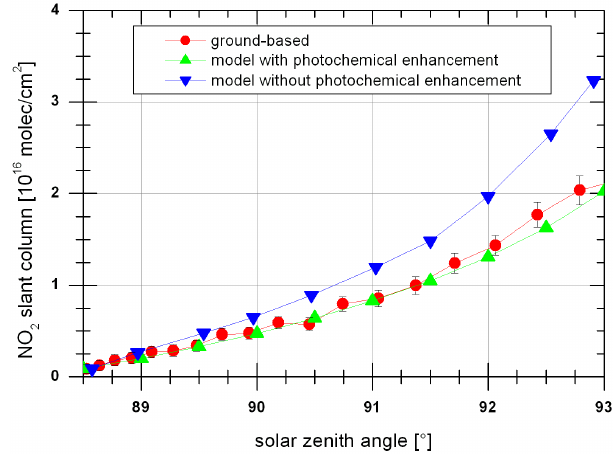
Fig. 3. Measurements (in red) and model calculations of NO 2 slant columns at Ny- ˚Alesund (79 ◦ N, 12 ◦ E) for 24 February as a function of SZA. The error bars represent the 2 σ error of the measurements. The model simulations with photochemical enhancement (in green) are smaller than the ones without (in blue) due to the changing SZA along the line-of sight of the